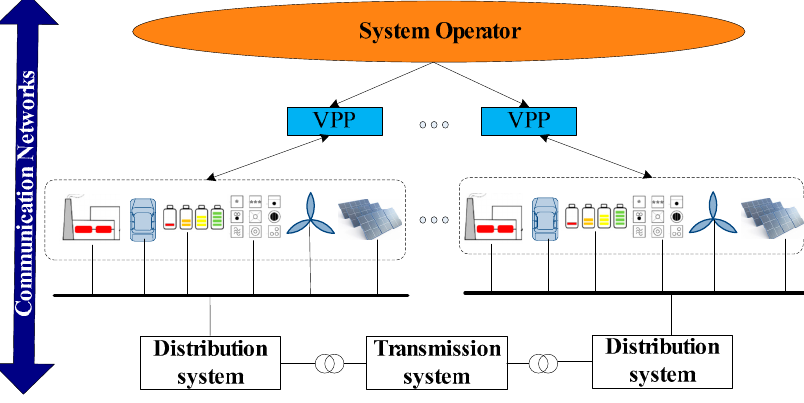
Figure 1. Concept of virtual power plant (VPP) and its components.